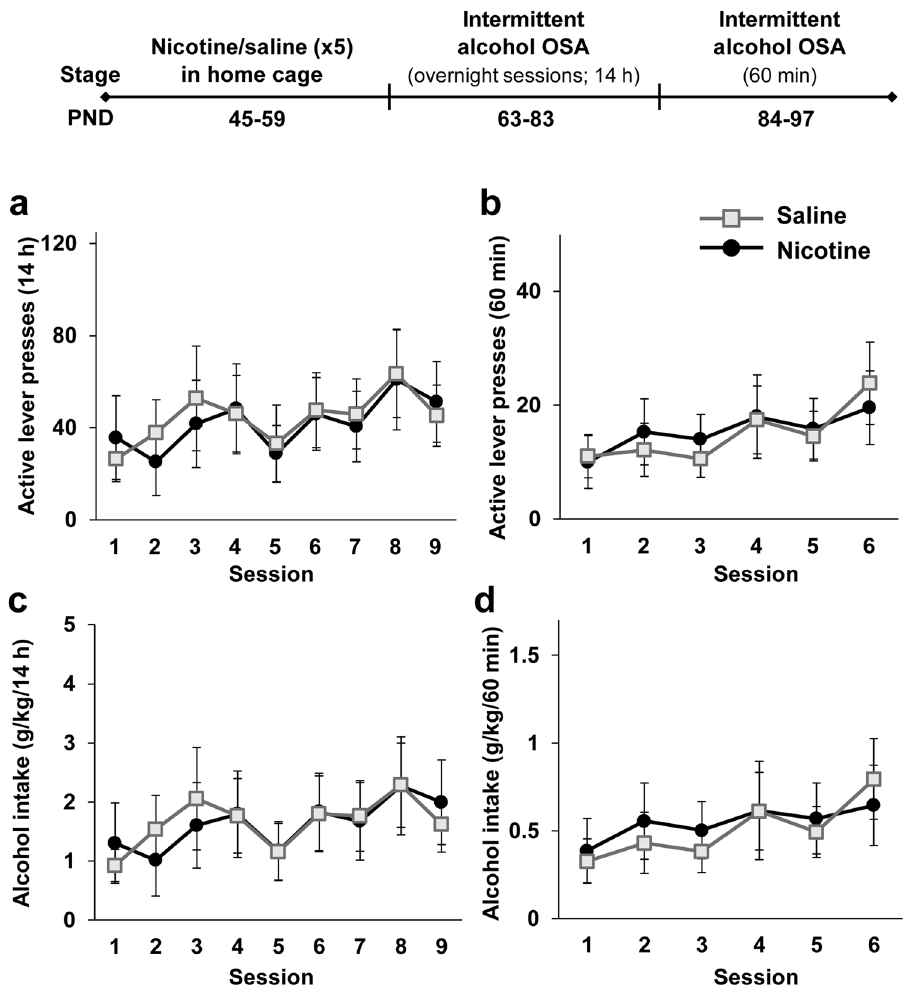
Figure 1. Adolescent nicotine pre-treatment in the home cage does not enhance operant alcohol self- administration in adulthood. Rats were treated with 5 nicotine or saline injections on PND 45–59, and remained in the home cages. On PND 63 rats began intermittent overnight operant alcohol self-administration (OSA) training three days a week (fixed ratio 1; FR1) for 3 weeks. On PND 84, rats began intermittent operant training (FR1) of 60 min, three days a week for 2 weeks. ( a–d ) Means ± SEM of the number of active lever presses ( a and b ) or alcohol intake normalized to body weight ( c and d ) during the overnight ( a and c ) or 60-min ( b and d ) sessions. Mixed-model ANOVA; Overnight sessions: A main effect of Session for active- lever presses [F(8,96) = 2.61, p < 0.05] and for alcohol intake [F(8,96) = 2.05, p < 0.05]; 60-min sessions: A main effect of Session for active-lever presses [F(5,60) = 5.15, p < 0.05] and for alcohol intake [F(5,60) = 4.67, p < 0.05]; No significant main effect of Pre-treatment and no significant Pre-treatment X Session interaction (all p’s > 0.05). n = 7 per